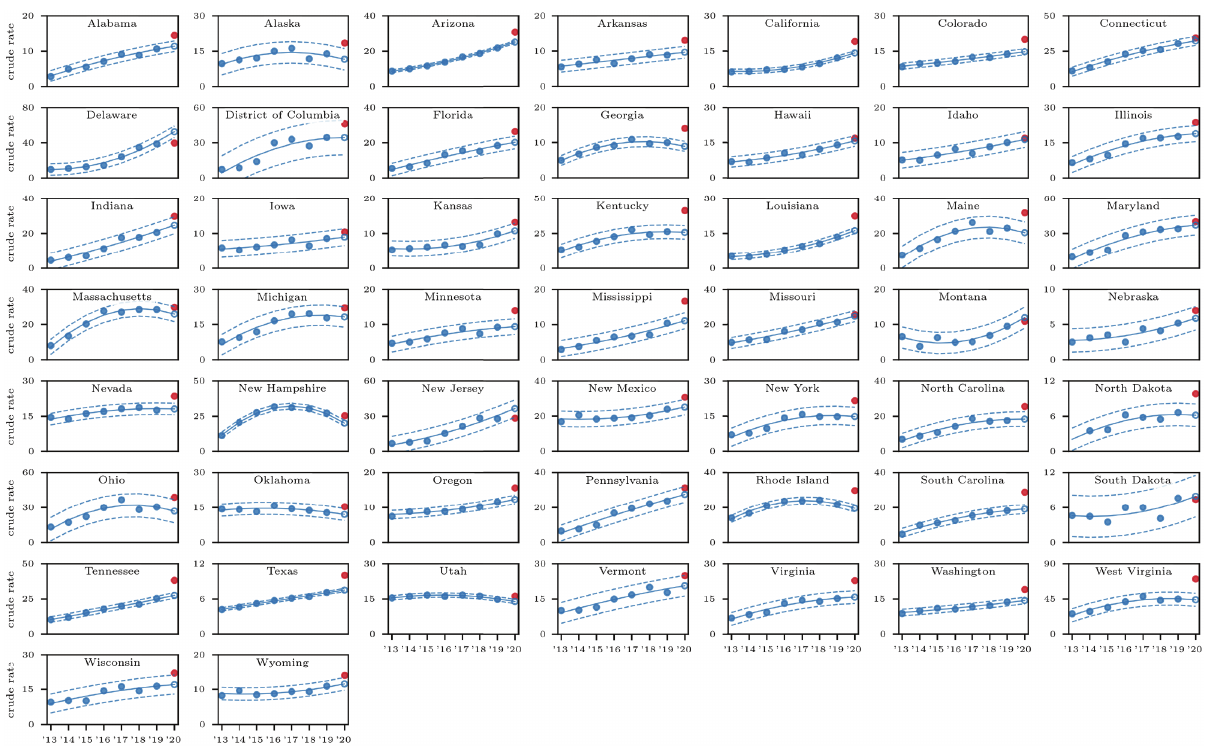
Fig 2. State-by-state fatal overdose trends for all races, all genders and all drug types, i.e. fentanyl (T40.4), methamphetamines (T43.6), prescription opioids (T43.6) and heroin (T40.1). Solid lines represent the 2013–2019 quadratic regression; dotted lines correspond to values three times above and below the regression by three times the standard deviation calculated from 2013–2019 data; the open circle is the 2020 projection, the filled red dot is the actual data. Note that in most states (but not all) an increasing 2013–2019 trend and that the 2020 value exceeds projections. In New Jersey and Delaware, crude rates were less than those predicted based on the 2013–2019 quadratic regression. There is insufficient data for North